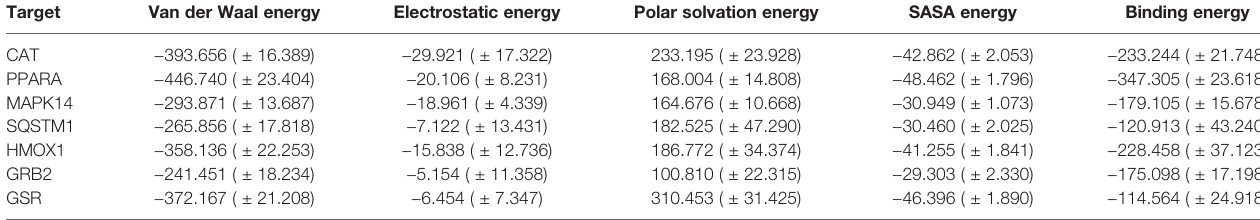
TABLE 3 | Binding free energy of CoQ10 and targets (kJ/mol). Target Van der Waal